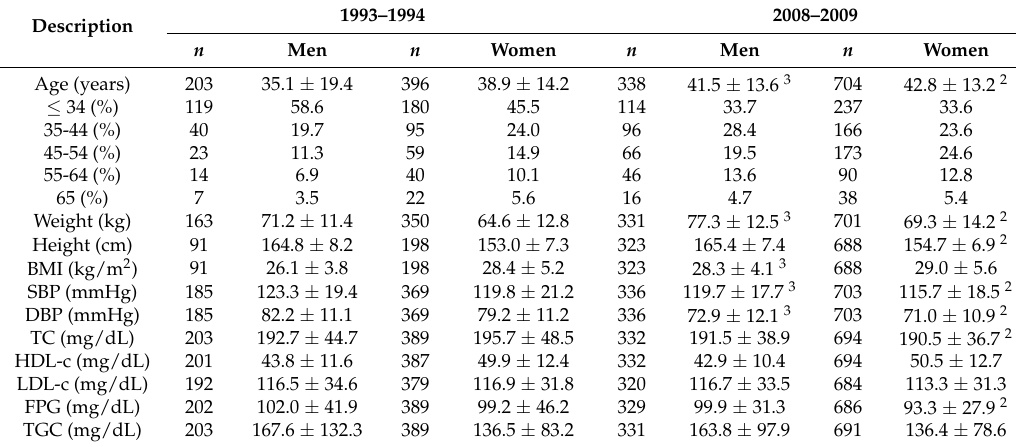
Table 1. Characteristics of the Central and South American study population by gender in 1993–1994 and 2008–2009 1